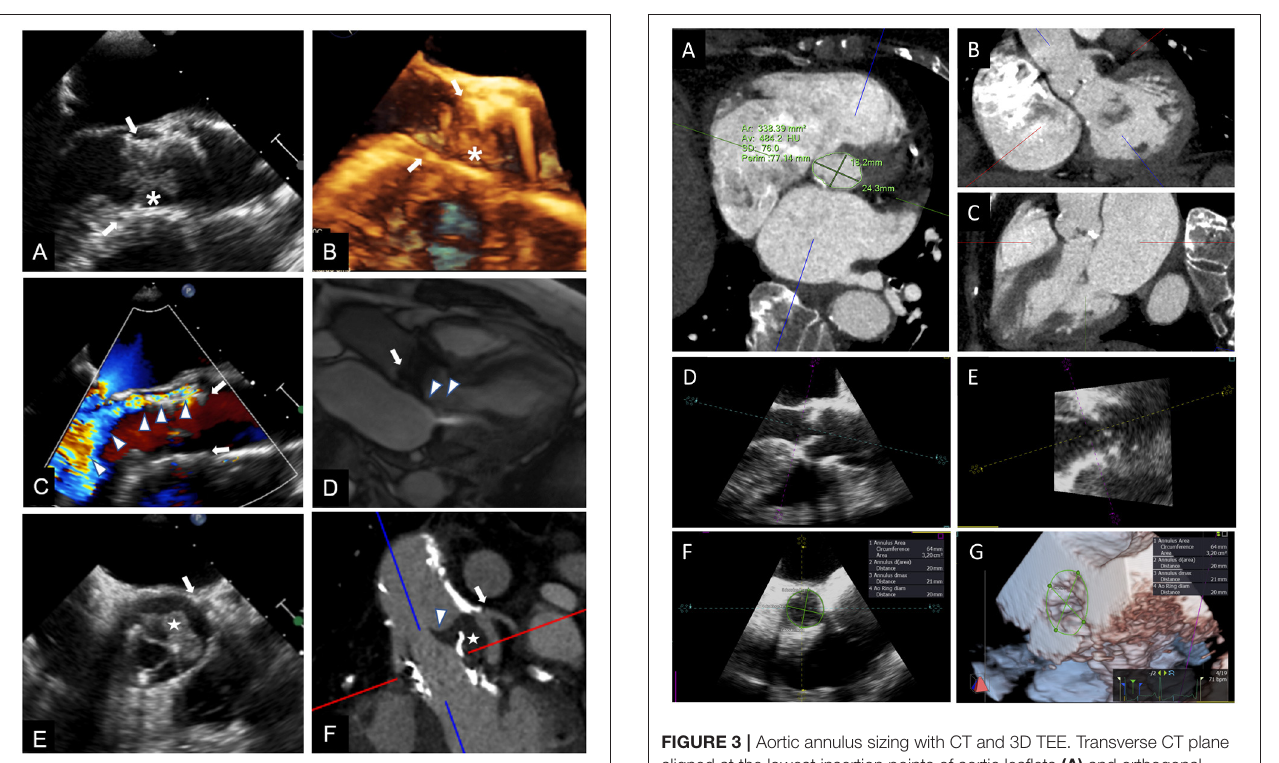
FIGURE 2 | Multimodality imaging for differential diagnosis of high trans-prosthetic gradients in patients with THV. Case 1 . TEE showing an isoechoic mobile mass (*) adherent to THV (arrows) cusps, causing valve obstruction; blood cultures confirmed infective endocarditis (A,B) . Case 2 . TEE revealing severe paravalvular (arrows) leak ( C , arrowheads); the regurgitant jet is also shown during CMR cine sequences ( D , arrowheads), and can be quantified using phase contrast sequences. Case 3 . TEE in a patient known for valve-in-valve procedure showing an isoechoic mass ( E , white star) in left coronary sinus, affecting cusp motion (arrowhead). CT (F) , confirmed the mass (white star) arising between the two valves, and whose features and density were consistent with thrombus.